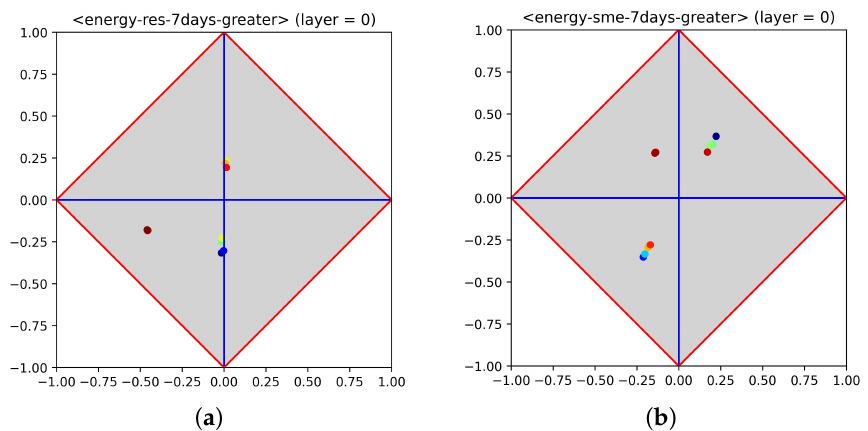
Figure 6. Class signatures of the datasets relating to residential loads ( a ) and enterprise loads ( b ). The reported signatures regard the greater-vs-rest binarization over a selected set of features (about 3% of the total number of features). ( a ) Loads of residential customers. ( b ) Loads of enterprise